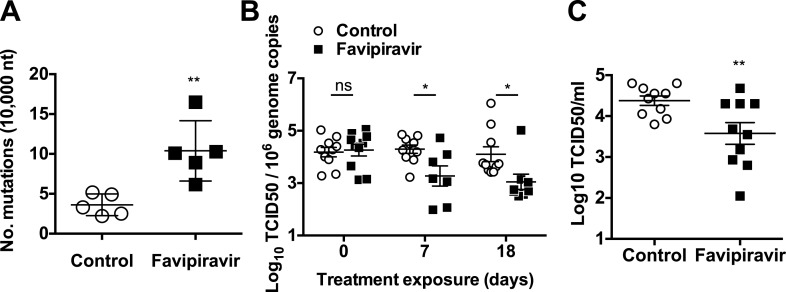
Increased mutation frequencies and decreased infectivity in virus populations isolated from favipiravir-treated animals.(A) Mutation frequency in virus isolated in faecal samples. Every value in the graph represents the virus mutation frequency in a different animal faecal sample after 18 days of treatment. Mutation frequencies are represented as the average number of nucleotide substitutions found in every 10,000 nucleotides sequenced. (0.001 < p < 0.05, **; t test). (B) Decreased infectivity in viral RNA isolated from favipiravir-treated animals. Viral RNA isolated from placebo and favipiravir-treated animal faecal samples was quantified and 2 × 105 genome copy equivalents were lipofected in semiconfluent BHK-21 cell monolayers. At 24 hr post-transfection, cells were freeze-thawed and the resulting virus yields determined by TCID50 assays in RAW264.7 cells. They are represented as the virus titres obtained per 106 genome copies isolated from the faeces of infected animals before treatment (day 0) and at treatment days 7 and 18. (C) MNV recovered from favipiravir-treated animals shows reduced replication yields. Virus isolated from animal faeces treated with favipiravir were first amplified in RAW264.7 cells allowing virus replication for 24 hr. Recovered viruses were titrated and 0.01 TCID50 units/cell applied to new RAW264.7 cell monolayers. Virus infections were collected at 8 hr post-infection and the cultures freeze-thawed to release infectious virus (**; p < 0.01; t test).